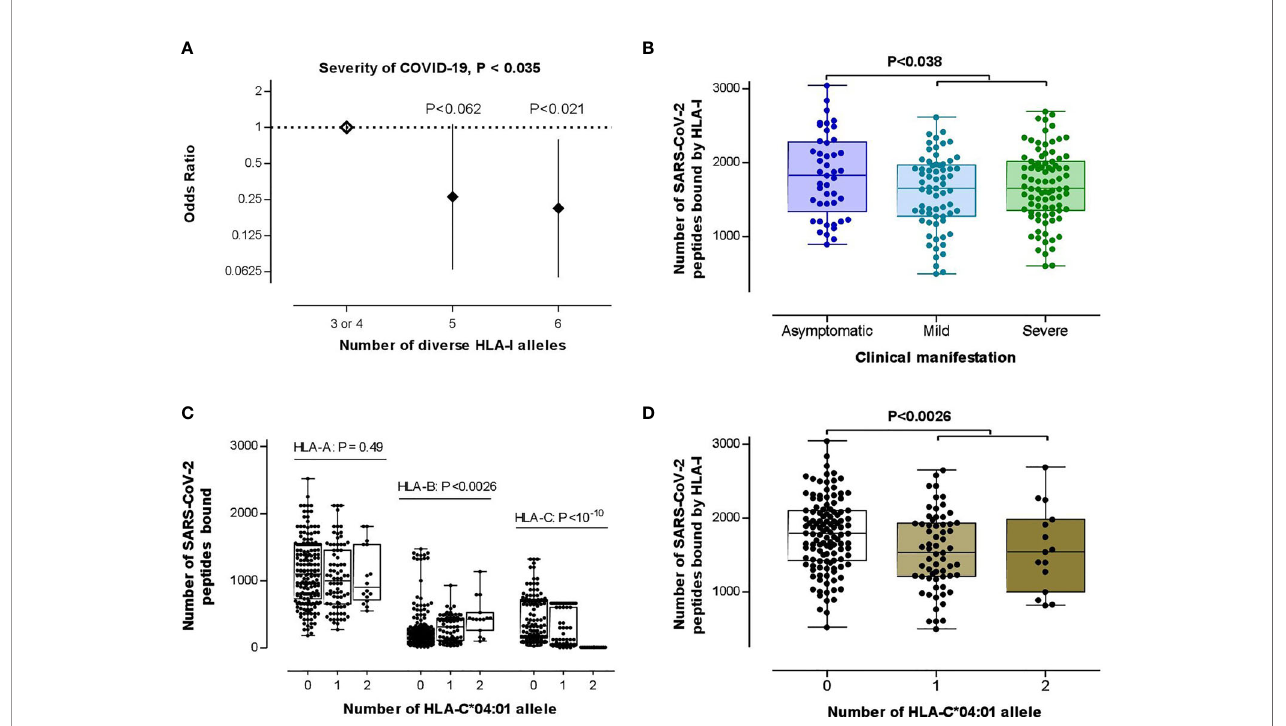
FIGURE 2 | Testing the theories on the association between HLA class I loci and COVID-19 severity. (A) HLA class I heterozygosity was a predictor of the disease severity. Error bars represent 95% con fi dence intervals (95% CI) of OR. (B) Differential HLA class I af fi nity to SARS-CoV-2 peptides was observed in asymptomatic patients (n=45) compared with mild/moderate (n=67) to severe (n=87) cases (P-value was driven by two-tailed t-test) for whom af fi nity data from the recent in silico study were available (26). (C) Effect of HLA-C*04:01 allelic load on HLA-A (n=281), HLA-B (n=276), HLA-C (n=234) binding capacity to SARS-CoV-2 peptides (P-value was driven by Kruskal – Wallis test). (D) HLA-C*04:01 allele carriage was associated with an attenuated average HLA class I binding af fi nity to SARS-CoV-2 peptides (P-value was driven by a two-tailed t-test of the data from 78 carriers vs 121 non-carriers). In (B – D) , box-plots indicate median and interquartile ranges of data distribution without four